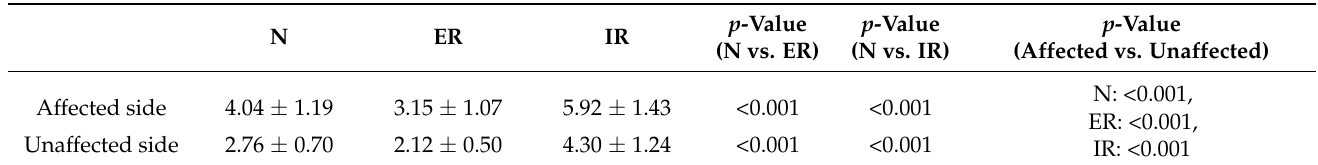
Figure 3. An illustrative case with unilateral frozen shoulder demonstrating the difference in inferior joint capsule (IJC) thickness in neutral position. ( A ) IJC thickness of the unaffected side. ( B ) IJC thickness of the affected side. Table 2. Comparison of the IJC thickness on US between the affected and unaffected shoulders and between three different positions.